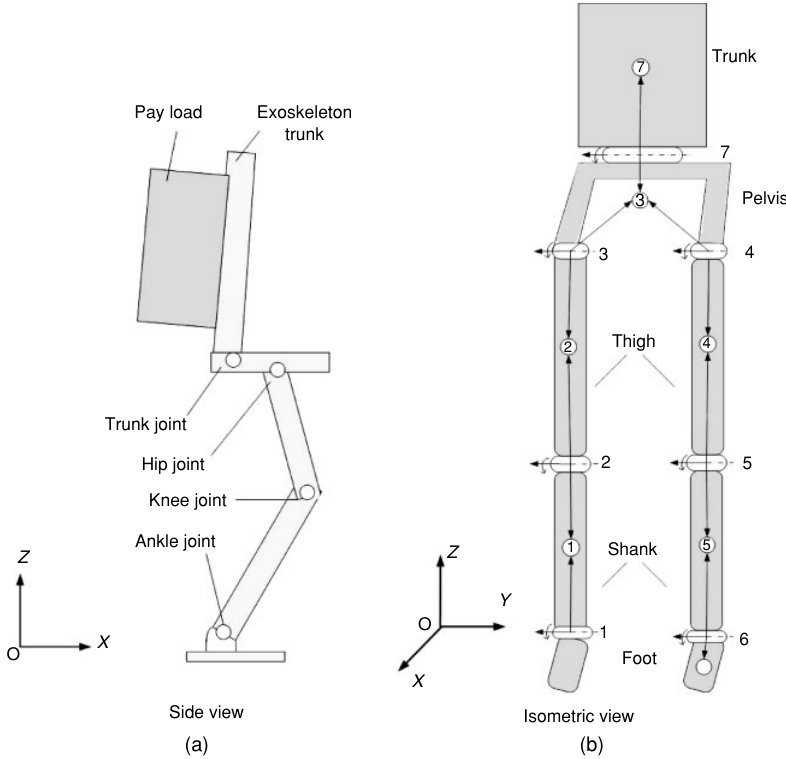
Figure 2 Model of the